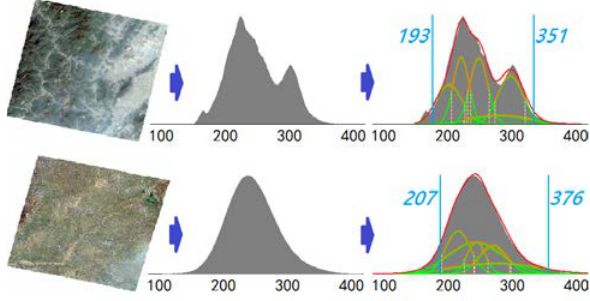
Figure 1. Histogram and Gaussian Mixture Model (red band) In figure 1, Gaussian Mixed Models are represented as red curves; Gaussian components are represented as green curves; “ Intensive-section ” of Gaussian components are represented as orange curves; G min and G max are represented as blue lines and blue numerals.